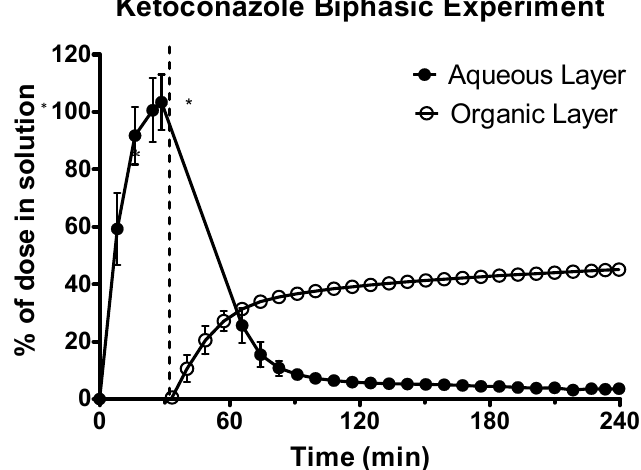
Figure 5. Drug release time profile for ketoconazole, dose equivalent to 20 mg API. Aqueous layer release is represented by filled circles. Organic layer data are represented by the hollowed circles. Dotted line indicates transition from gastric sector to intestinal sector. Each data point represents the mean ± SD ( n = 3). * indicates where UV blackout has occurred in the aqueous phase due to precipitation.